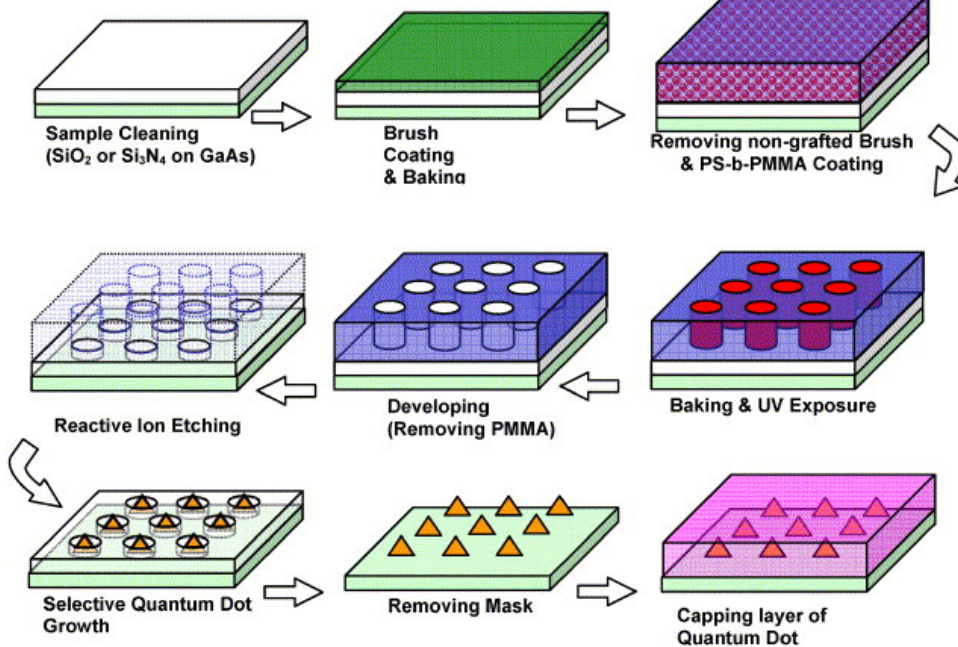
Figure 8. Selective growth of QDs by diblock copolymer lithography. Reprinted with permission from ref. [46] © Elsevier. Copyright 2006 Journal of Crystal Growth. from ref. [46] © Elsevier. Copyright 2006 Journal of Crystal